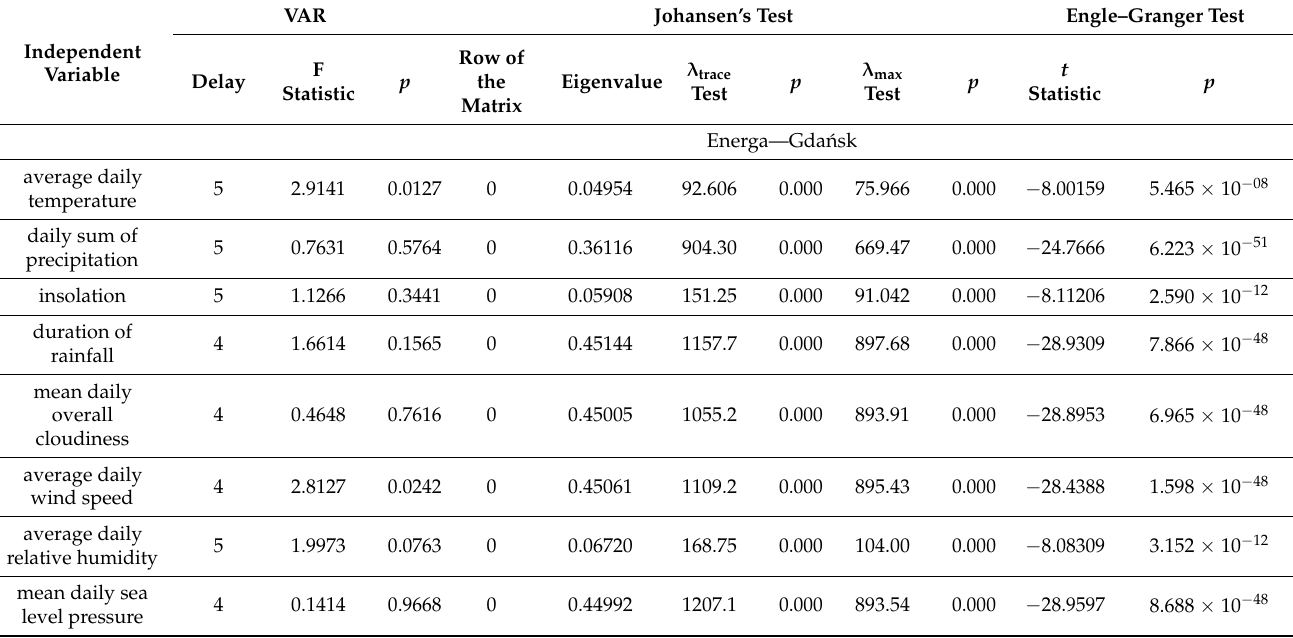
Table 6. VAR causality test results for trading volume and weather factors with co-integration analysis.